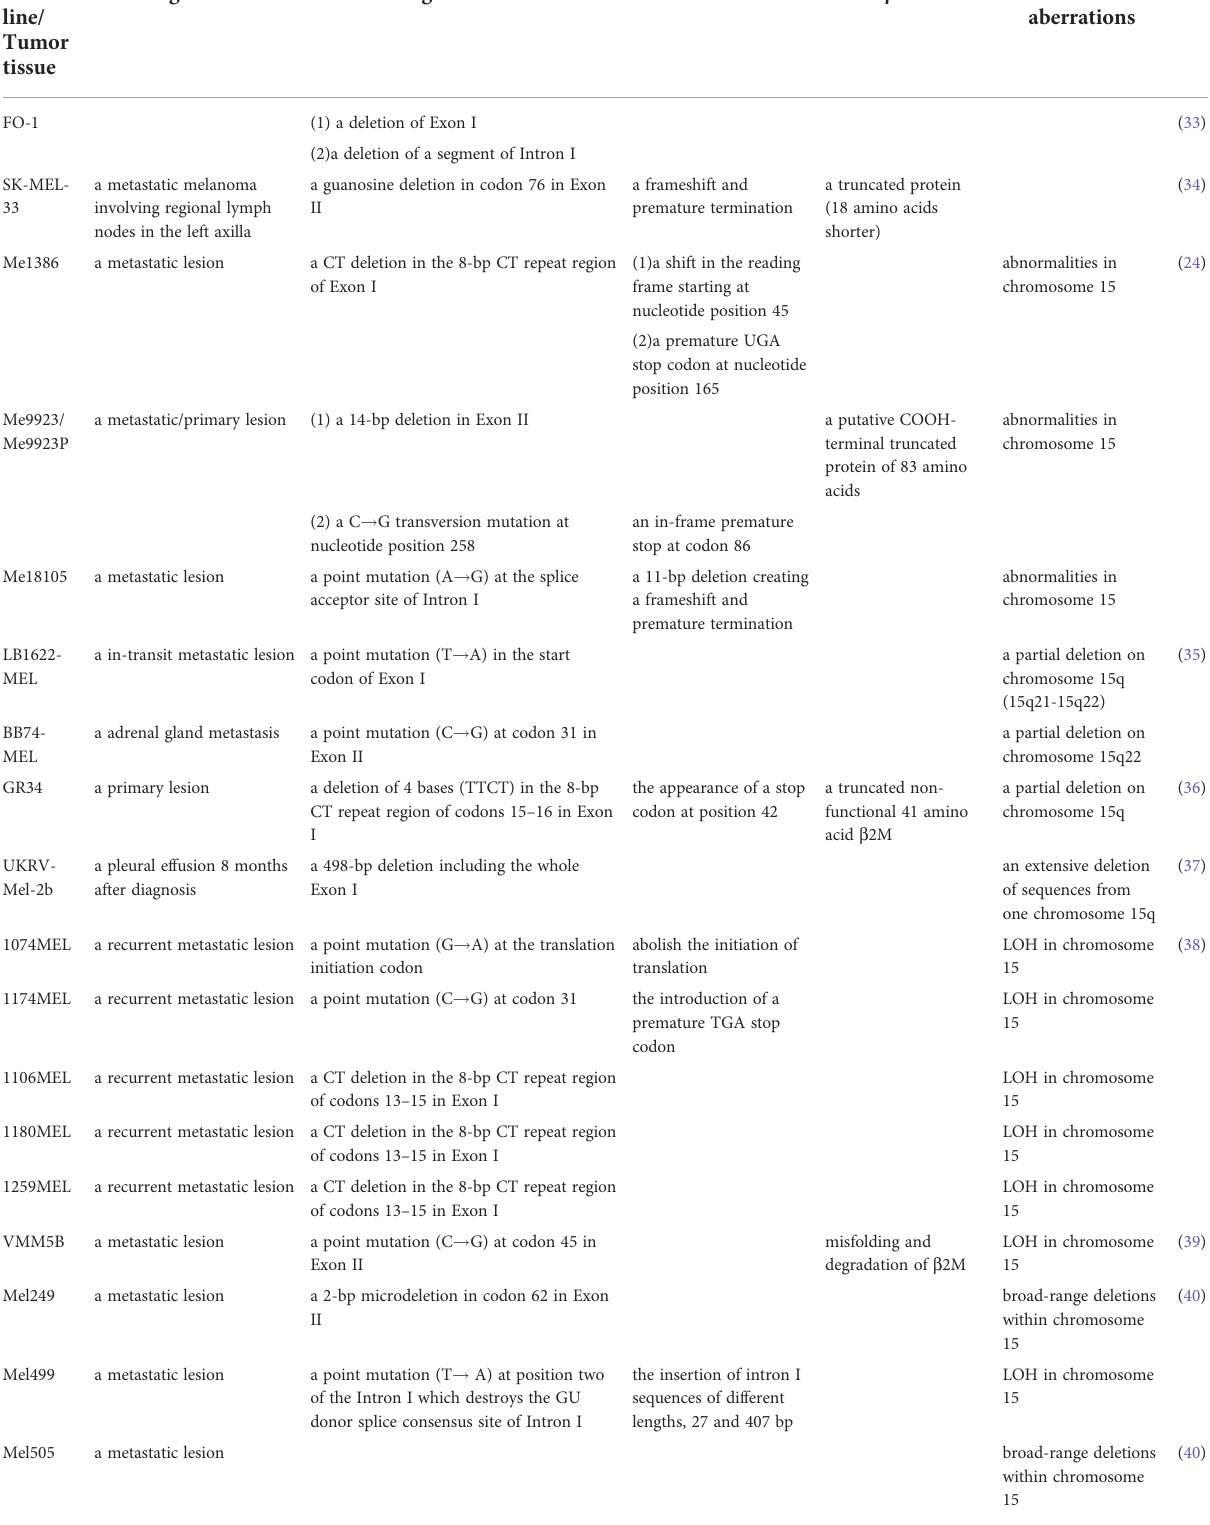
TABLE 1 Summary of B2M mutations in